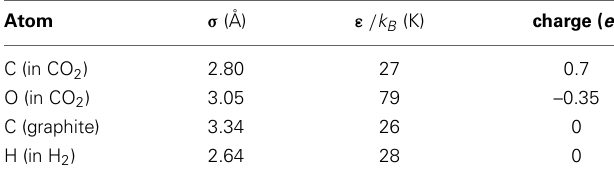
Table 1 | Interaction potential parameters used in